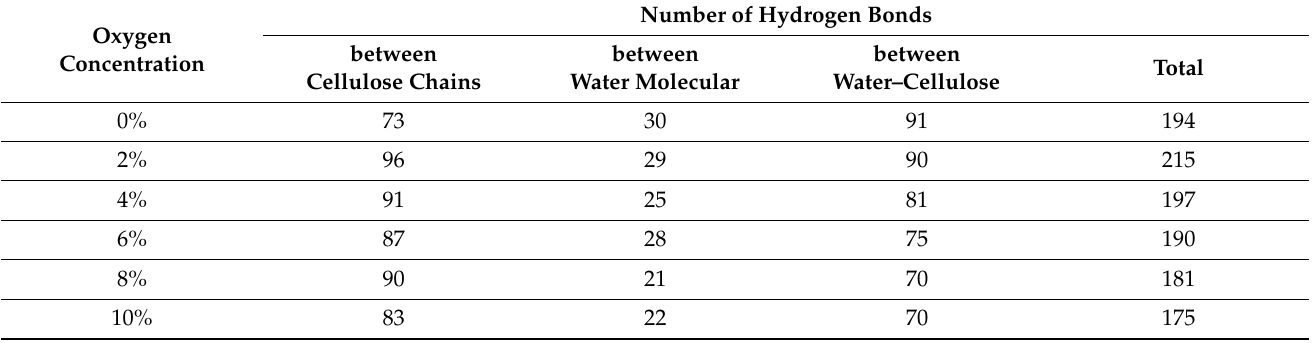
Table 5. Alterations in the various hydrogen